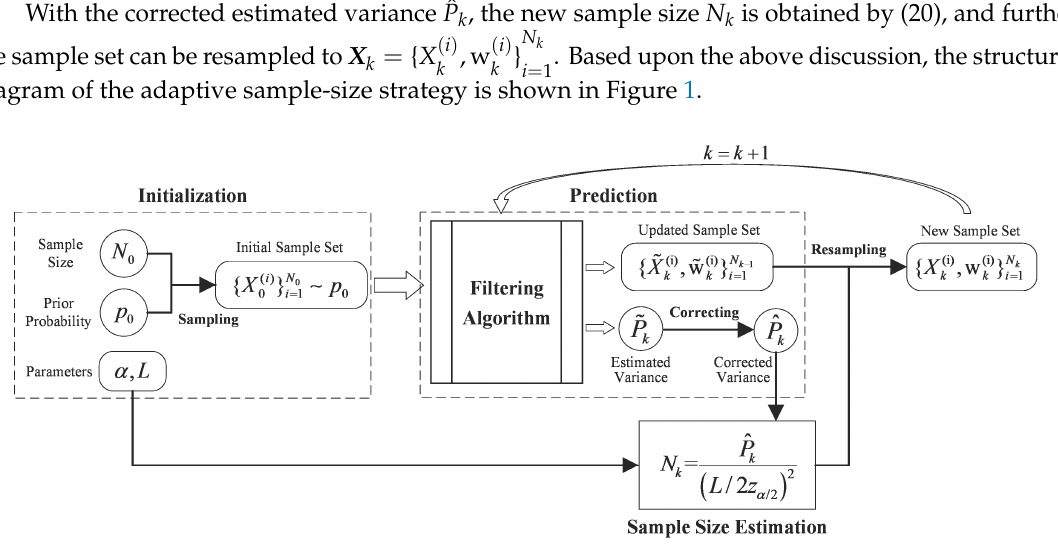
Figure 1. Structural diagram of the adaptive sample-size strategy.